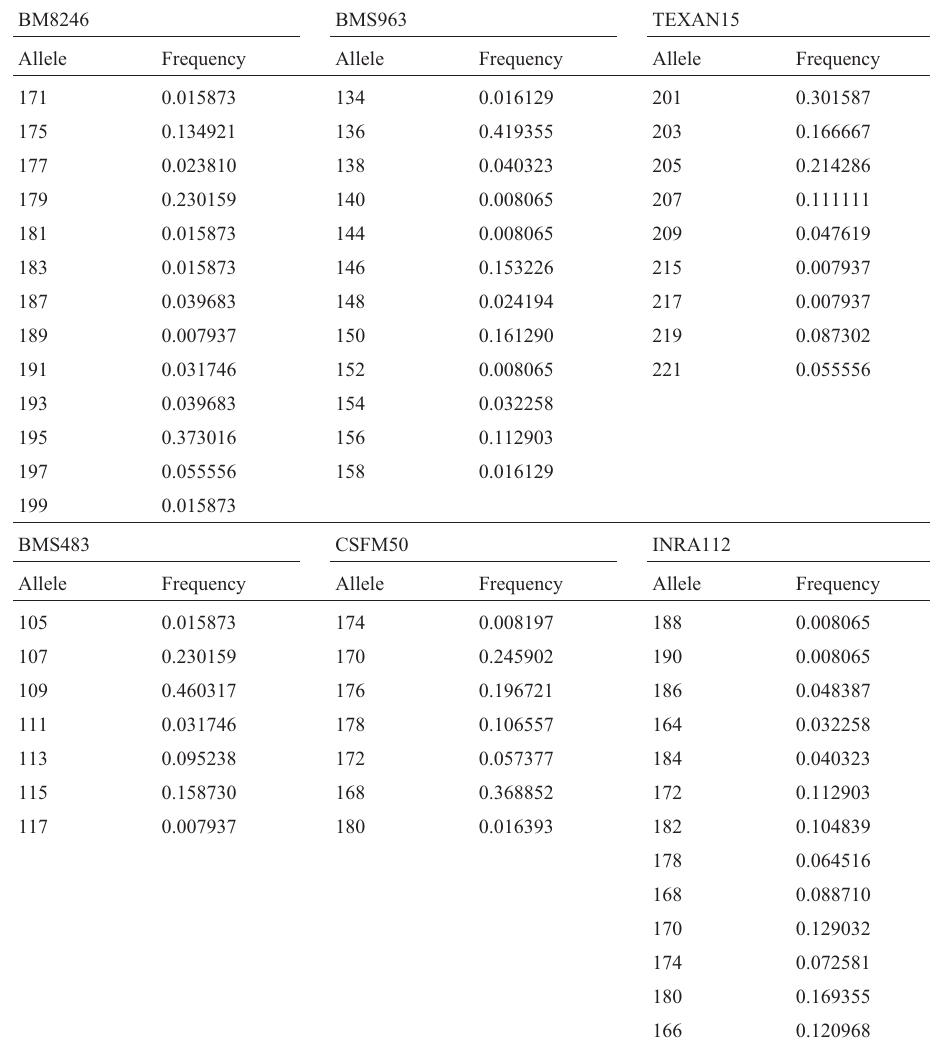
Table II - Allele frequencies of microsatellites.